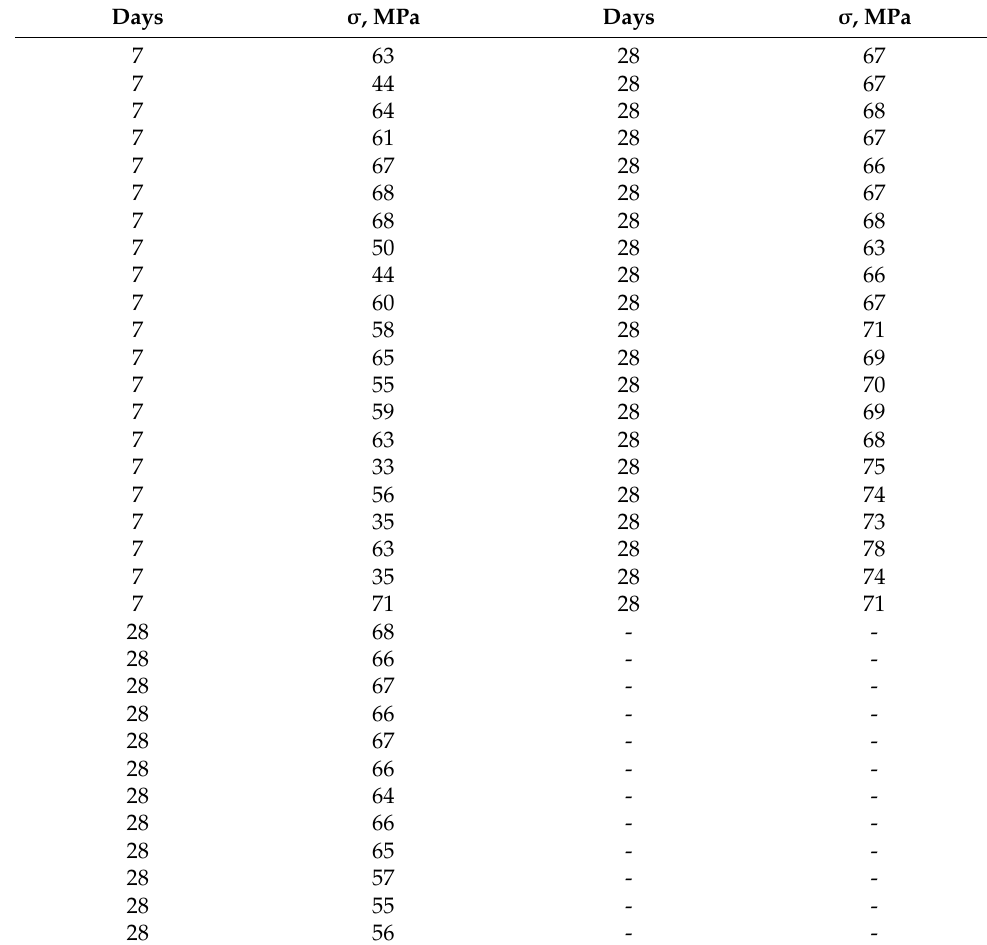
Table A3. Compressive strength of the concrete mixture f’ c = 44